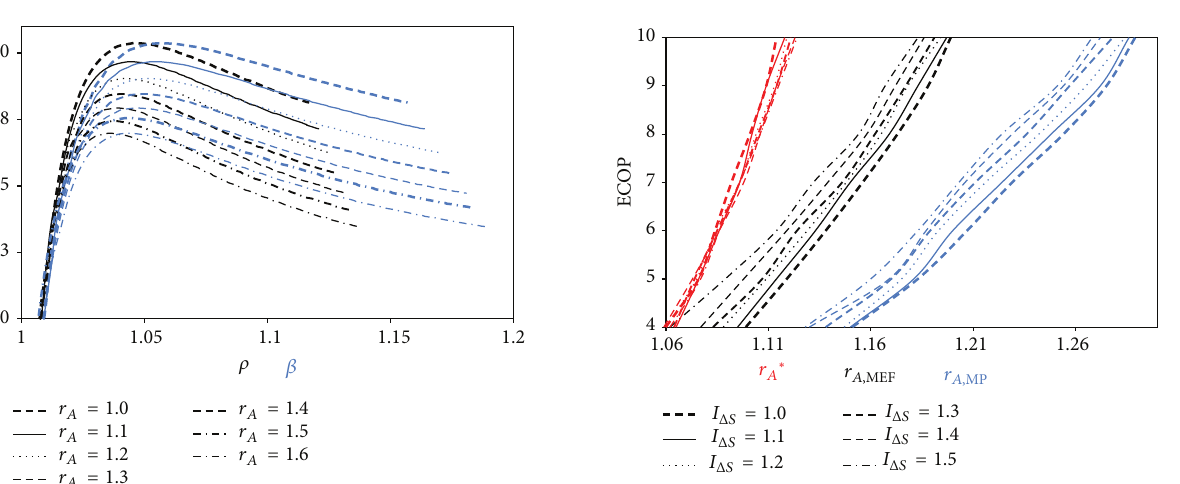
= 𝑇 = 300 K, 𝑋 = 0.3 , and 𝜉 = 0.02 ). 0 𝐿